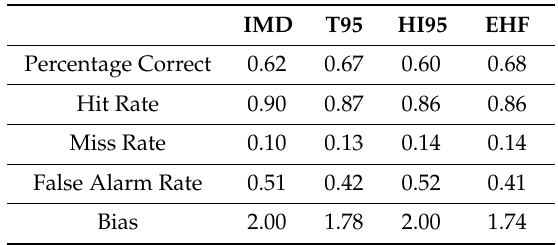
Table 8. Skill scores evaluating the performance of the climate-based heat wave definitions against the Twitter based